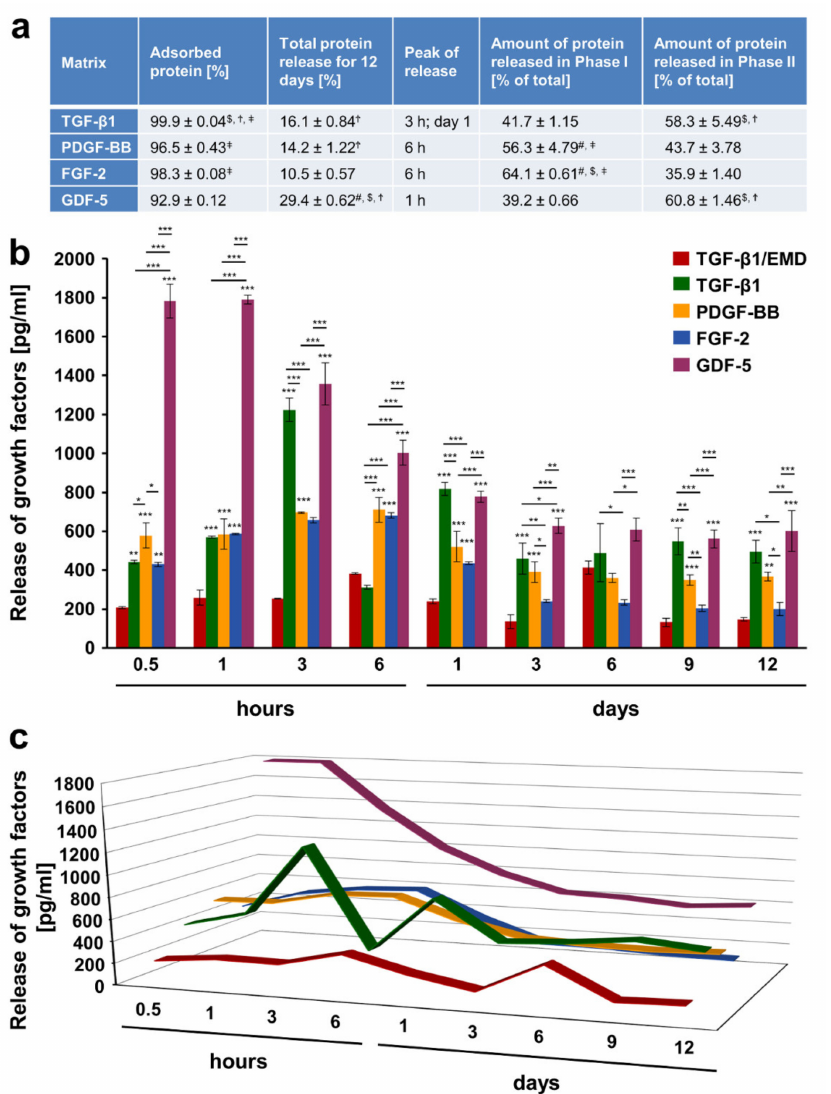
Figure 2. Adsorption and release of various recombinant growth factors from vCM. The vCM was incubated for 10 min at room temperature in phosphate-buffered saline (PBS) containing 100 ng/mL of TGF- β 1, PDGF-BB, FGF-2, or GDF-5. ( a ) Colorimetric ELISAs were performed for: (1) quantitative evaluation of adsorption rate (expressed in percent) of each of the four growth factors; (2) quantitative evaluation of total protein release (expressed as percent of adsorbed protein) from vCM for a 12-day period for each of the growth factors; (3) determination of the peak of release, i.e., the time point at which the highest growth factor release from the vCM coated with the respective growth factor was observed; (4) quantitative evaluation of growth factor release in phase I expressed as percent of the total release for the entire 12-day period (taken as 100%); (5) quantitative evaluation of growth factor release in phase II expressed as in (4). The peak release marks the end of phase I whereas phase II spans the period immediately after the peak of the release until day 12. Means ± SD from three independent experiments and significant differences (p < 0.05) between the experimental groups are shown. Significance was indicated with the following symbols: # denotes significantly higher than TGF- β 1, $ denotes significantly higher than PDGF-BB, Ϯ denotes significantly higher than FGF-2, and ǂ denotes significantly higher than GDF-5. ( b ) Release of TGF- β 1 from vCM coated with EMD as well as release of TGF- β 1, PDGF-BB, FGF-2, and GDF-5 from vCMs coated with each of the respective recombinant growth factors was quantified in conditioned PBS solution collected from the matrices at the indicated time intervals over a 12-day period. Means ± SD from three independent experiments and significant differences, *** p < 0.001, ** p < 0.01, * p < 0.05, between experimental groups are shown. ( c ) A three-dimensional graph for the data present in ( b ) is used for better visualization of the peaks and speed (slope of the line) of growth factor release discussed in the